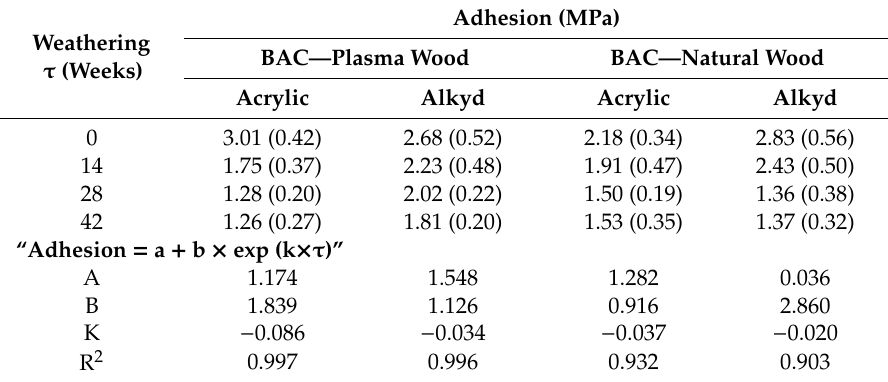
Table 4. The significant negative e ff ect of the outdoor weathering on the adhesion between the coating (acrylic or alkyd) and the Norway spruce wood pre-treated with fungicide BAC —subjected to or not subjected to plasma